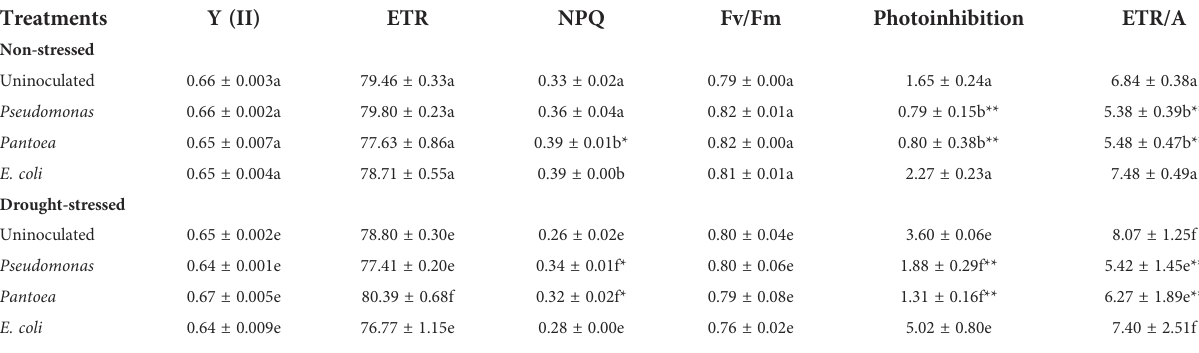
TABLE 2 Chlorophyll fl orescence parameters (photochemical ef fi ciency of photosystem II [Y (II)], electron transport rate (ETR), non- photochemical quenching (NPQ), maximum photosynthetic ef fi ciency of PSII (Fv/Fm), photoinhibition and oxidative stress (ETR/A)) of drought- stressed and non-stressed (well-watered) Hordeum vulgare inoculated with three bacterial strains ( Pseudomonas sp. (ITS Group 11), Pantoea sp. (ITS Group 2), or E. coli ).